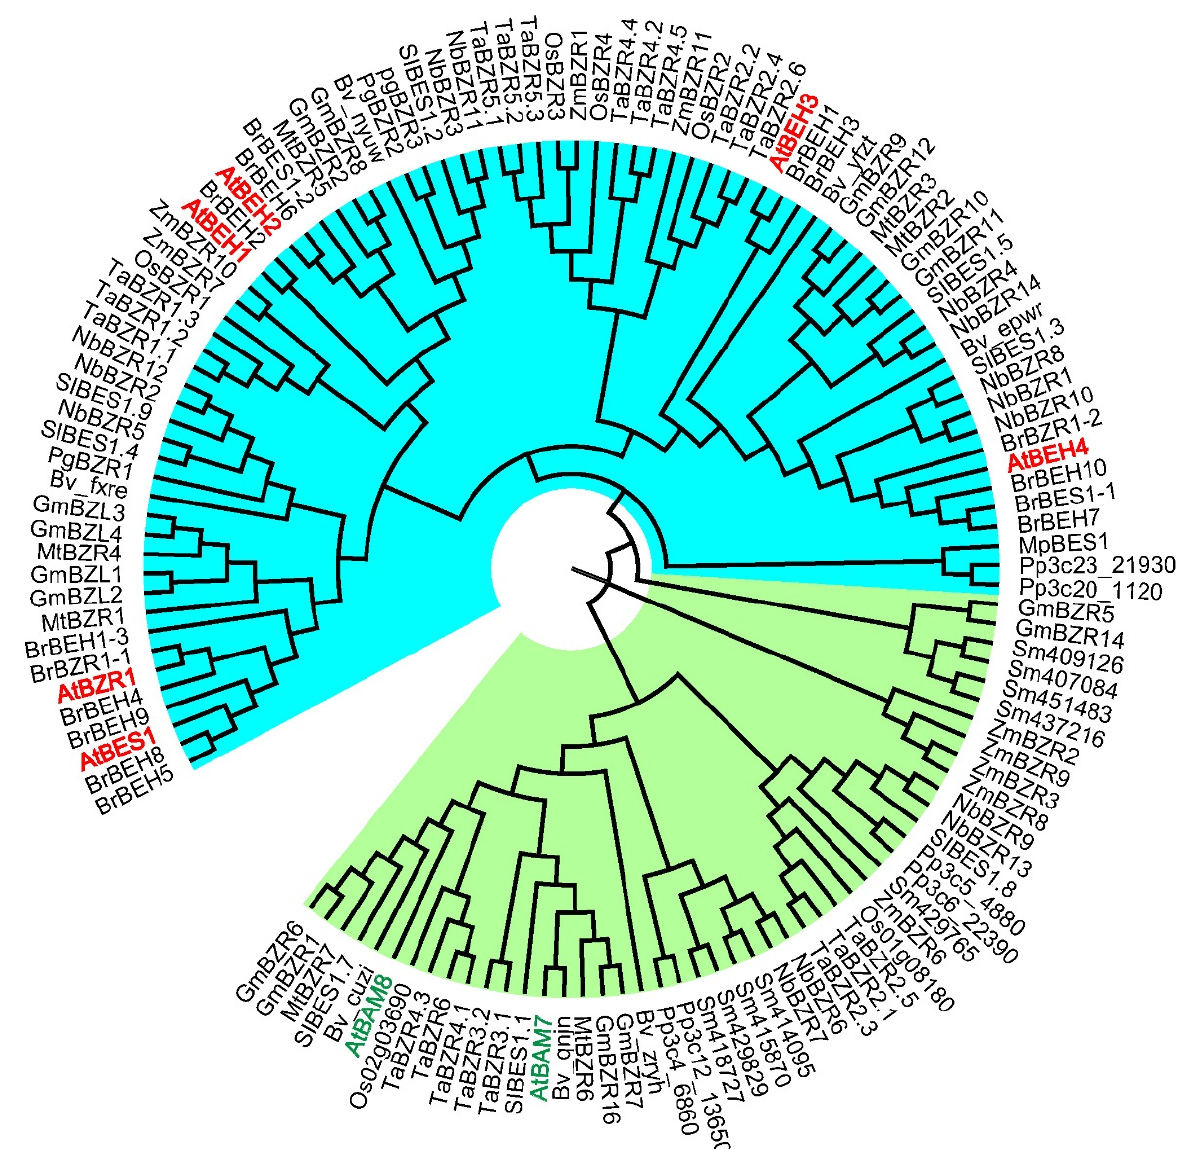
Figure 1. BES1/BZR1 family members and their phylogenic tree from Arabidopsis and a number of representative species. Phylogenetic relationships among BES1/BZR1 family proteins of the dicotyledonous plant species including Arabidopsis thaliana (At) [22,28,54–56], Solanum Lycopersicum (Sl) [45], Nicotiana benthamiana (Nb) [39], Medicago truncatula (Mt) [40], Glycine max (Gm) [44,52,53], Brassica rapa (Br) [43], Triticum aestivum (Ta) [36,38], and Beta vulgaris (Bv) [48]; monocotyledonous Oryza sativa (Os) [42,57], and Zea mays (Zm) [37,41]; and lower plant species Selaginella moellendorffi (Sm) [34,57,58], Physcomitrella patens (Pp) [27,34,57], and Marchantia polymorpha (Mp) [34]. BES1/BZR1 homologs are highlighted in the blue region and putative BAM homologs are highlighted in the green region. BES1/BZR1 family members from Arabidopsis are marked in red color. AtBAM7 and AtBAM8 are marked in green color. The phylogenetic tree was reconstructed using the neighbor-joining method. The full-length protein sequences for different species were obtained from the Ensembl database or corresponding references (Supplementary Table S1). The software MEGA-X was used to reconstruct the phylogenic tree, and FigTree (http://tree.bio.ed.ac.uk/software/figtree/, accessed on 1 June 2022) was used for visualization.